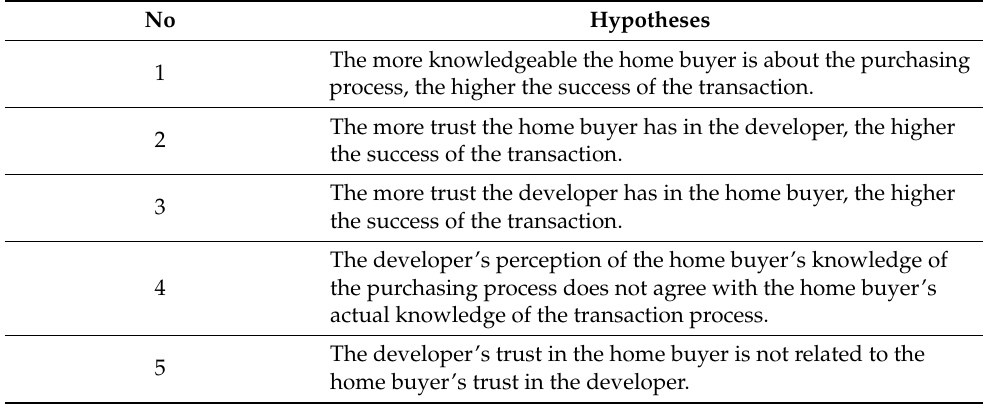
Table 1. Modeling